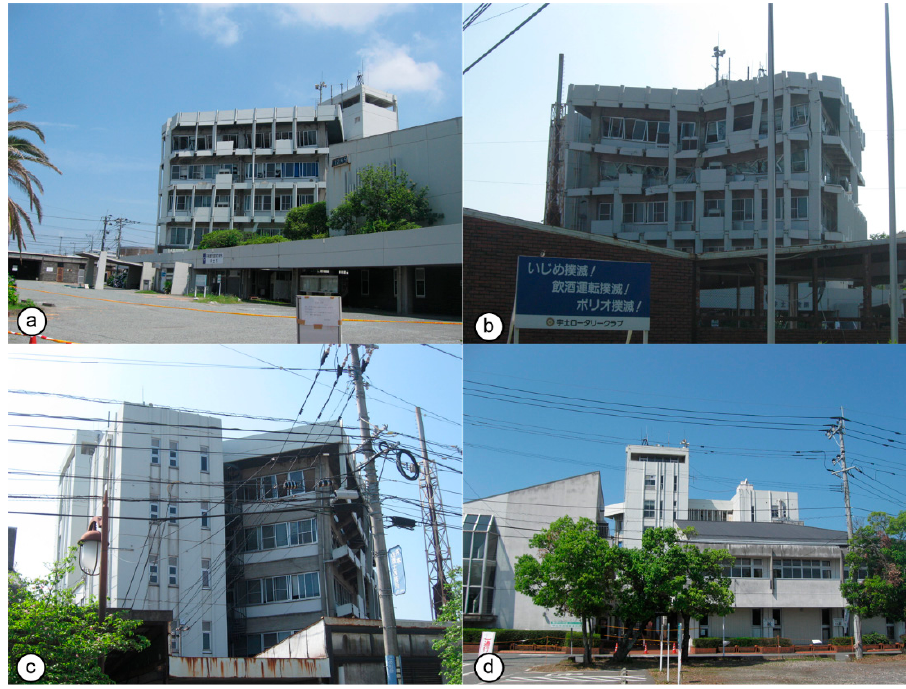
Figure A2. Views of the main Uto City Hall building. Photographs were taken from ( a ) the south, ( b ) the west, ( c ) the north, and ( d ) the northeast.